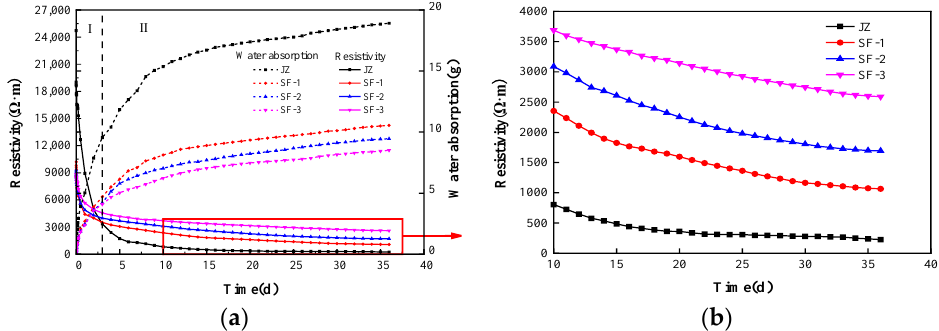
Figure 7. Changes in water absorption and resistivity of cement mortar with different SF contents over time: ( a ) Macroscopic damage; ( b ) Partially enlarged drawing.